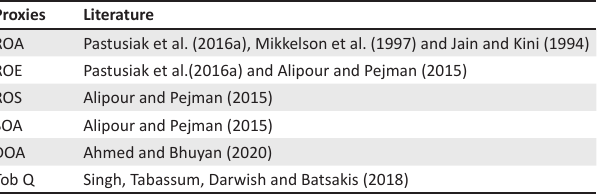
TABLE 3: Independent variables and their measurements for each proxy. TABLE 2: Prior literature on firm performance measured by various proxies.